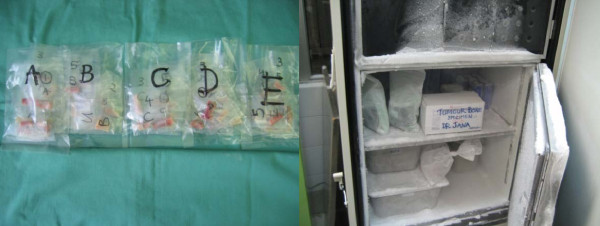
Specimens packed separately, labeled and put in -80 degrees freezer.